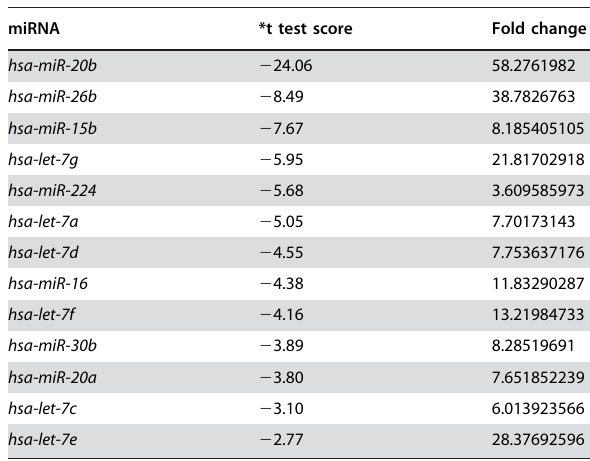
Table 1. microRNAs down-regulated in DFOM-induced CNE. .. ... .... ... ... .... ... ... .... ... ... .... ... ... .... ... ... .... ... ... .... . miRNA *t test score